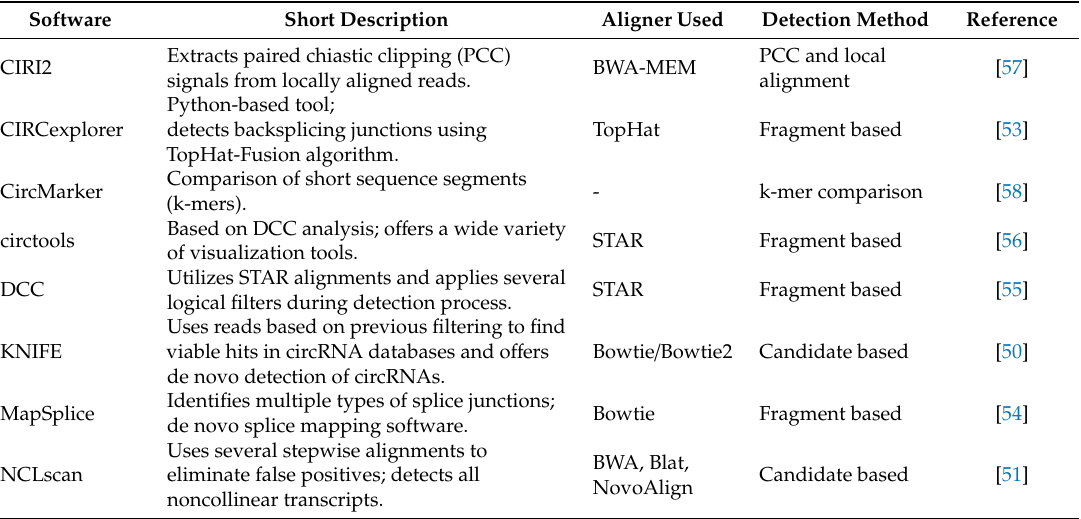
Table 2. Selected computational tools for circRNA detection in RNA-seq